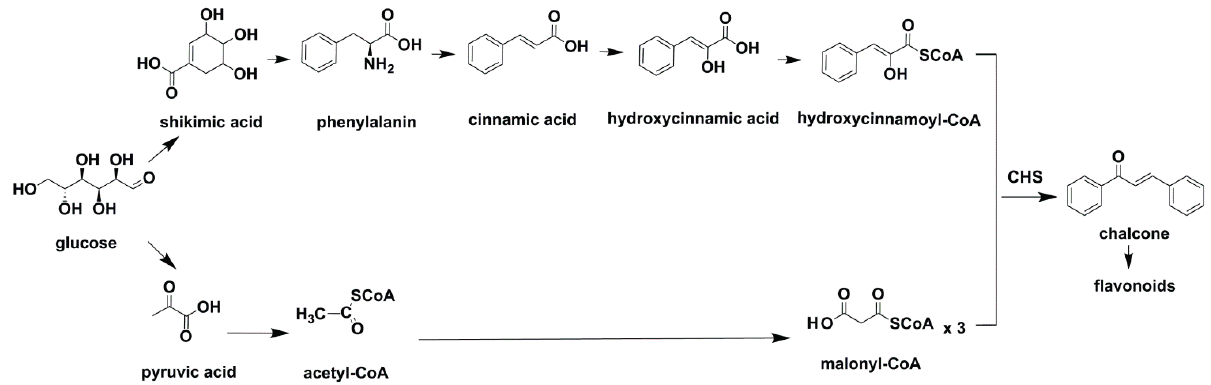
Figure 1. Scheme of the biosynthetic pathways of polyphenolic compounds [25].